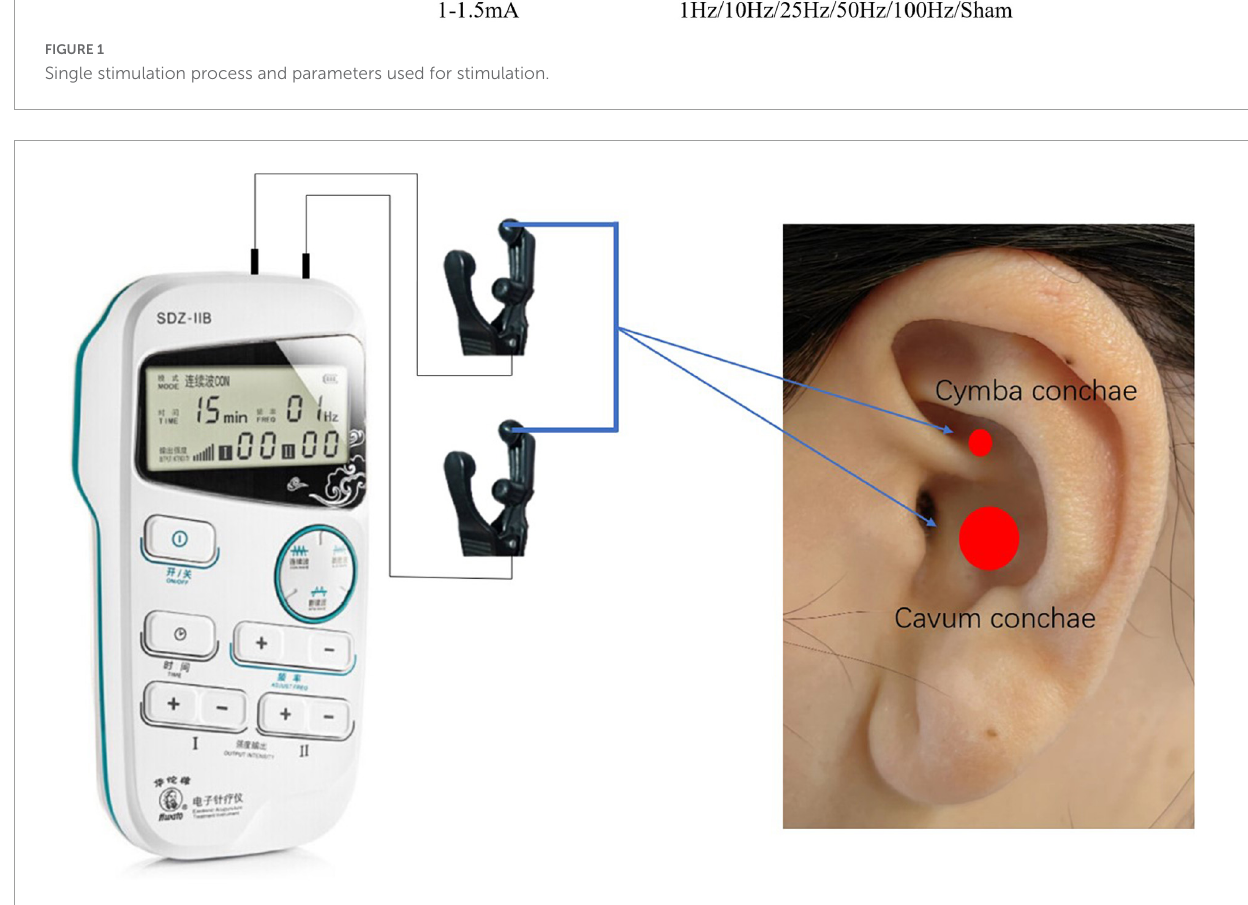
FIGURE2 Stimulation sites of